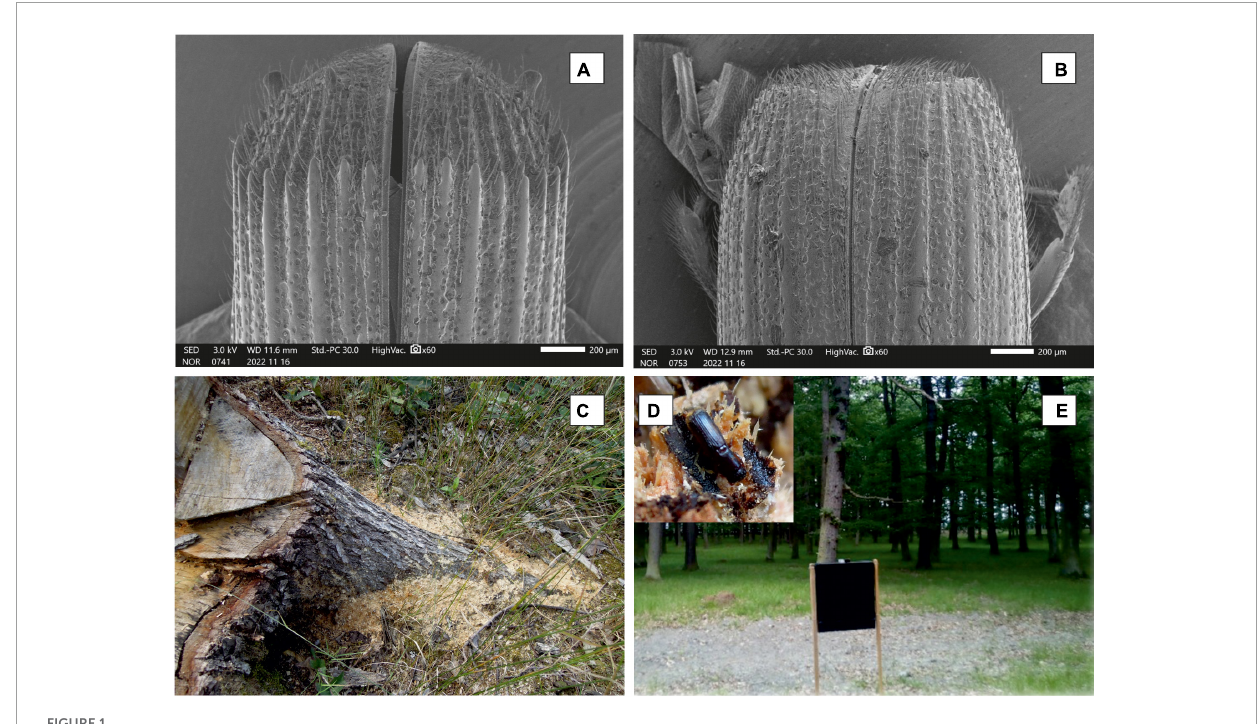
FIGURE1 Male (A) and female (B) declivity in Platypus cylindrus . SEM micrographs were acquired by scanning electron microscopy using a JEOL JSM-IT500HR instrument (JEOL, Tokyo, Japan) operating at 3 kV. (C) ... dust at base of stump resulting from feeding of the ambrosia beetle